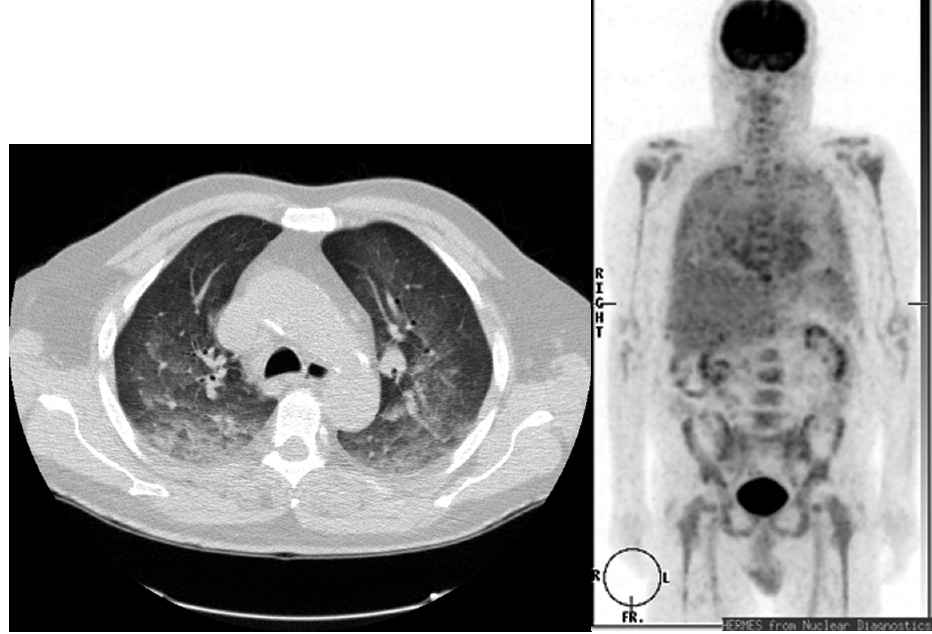
Figure 1. Pulmonary toxicity in a patient with chronic myelomonocytic leukemia treated with etoposide. A computer tomography (CT) scan ( left panel ) shows diffuse ground glass and reticular opacities in bilateral posterior pulmonary segments. A coronal 18 F-fluorodeoxyglucose (FDG) positron emission tomography (PET) scan ( right panel ) demonstrates bilateral diffuse pulmonary uptake (Used with permission from [29]).